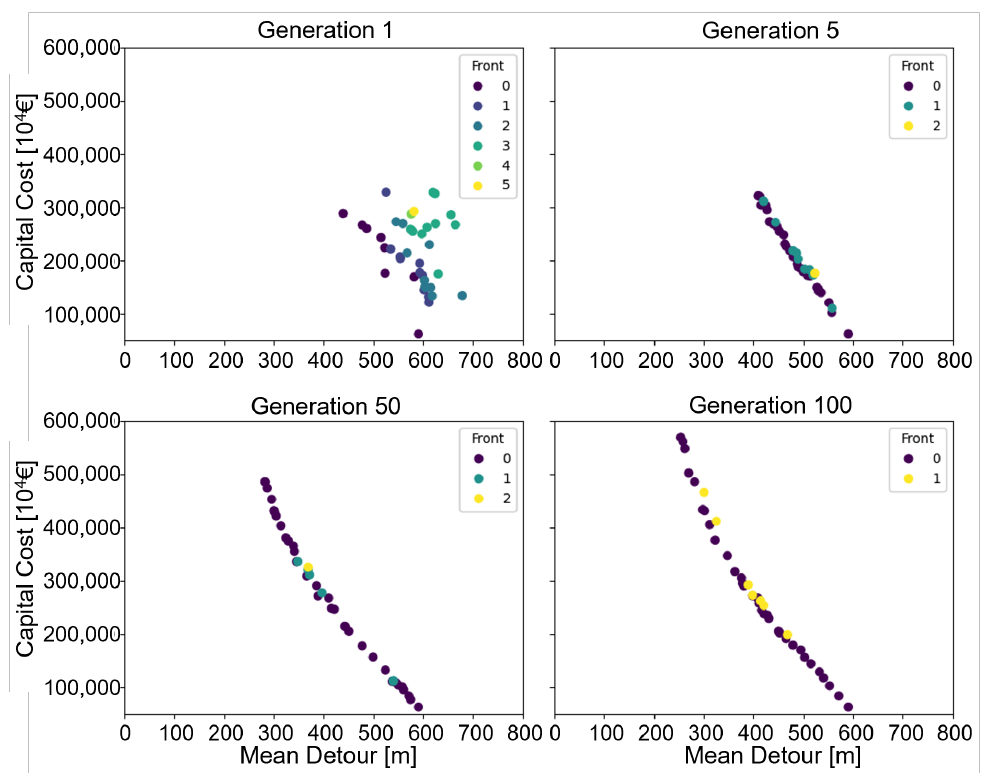
Figure 6. Development of results across